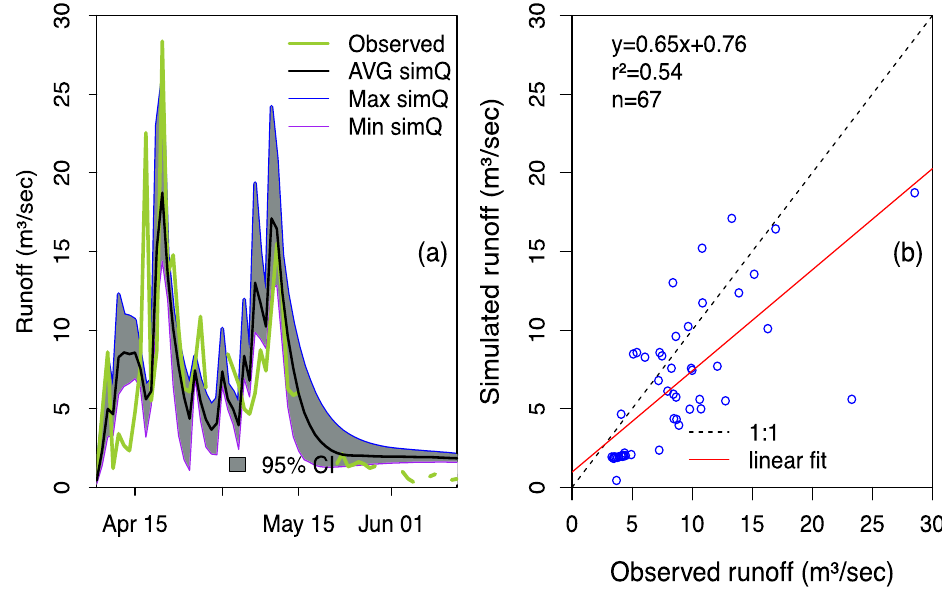
Figure 7. ( a ) Observed and simulated runoff (Q) for Simba River along with uncertainty band, for calibration period April–June 1980 ( b ) Relationship between the average simulated runoff (AVG) and observed runoff as depicted using linear regression.